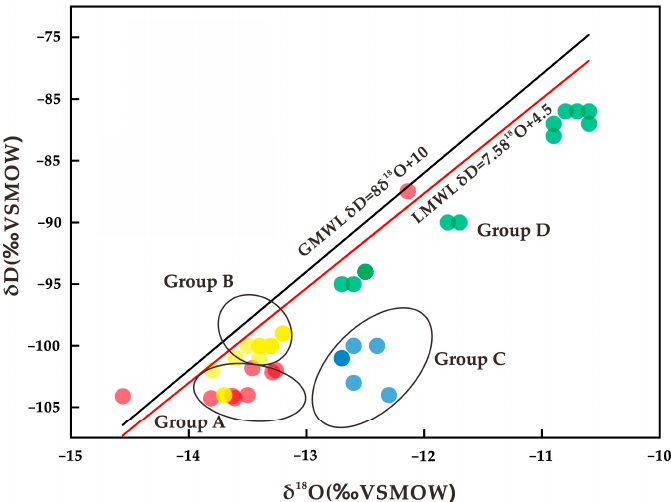
Figure 5. δ 2 H– δ 18 O relationships of water samples from the study area.